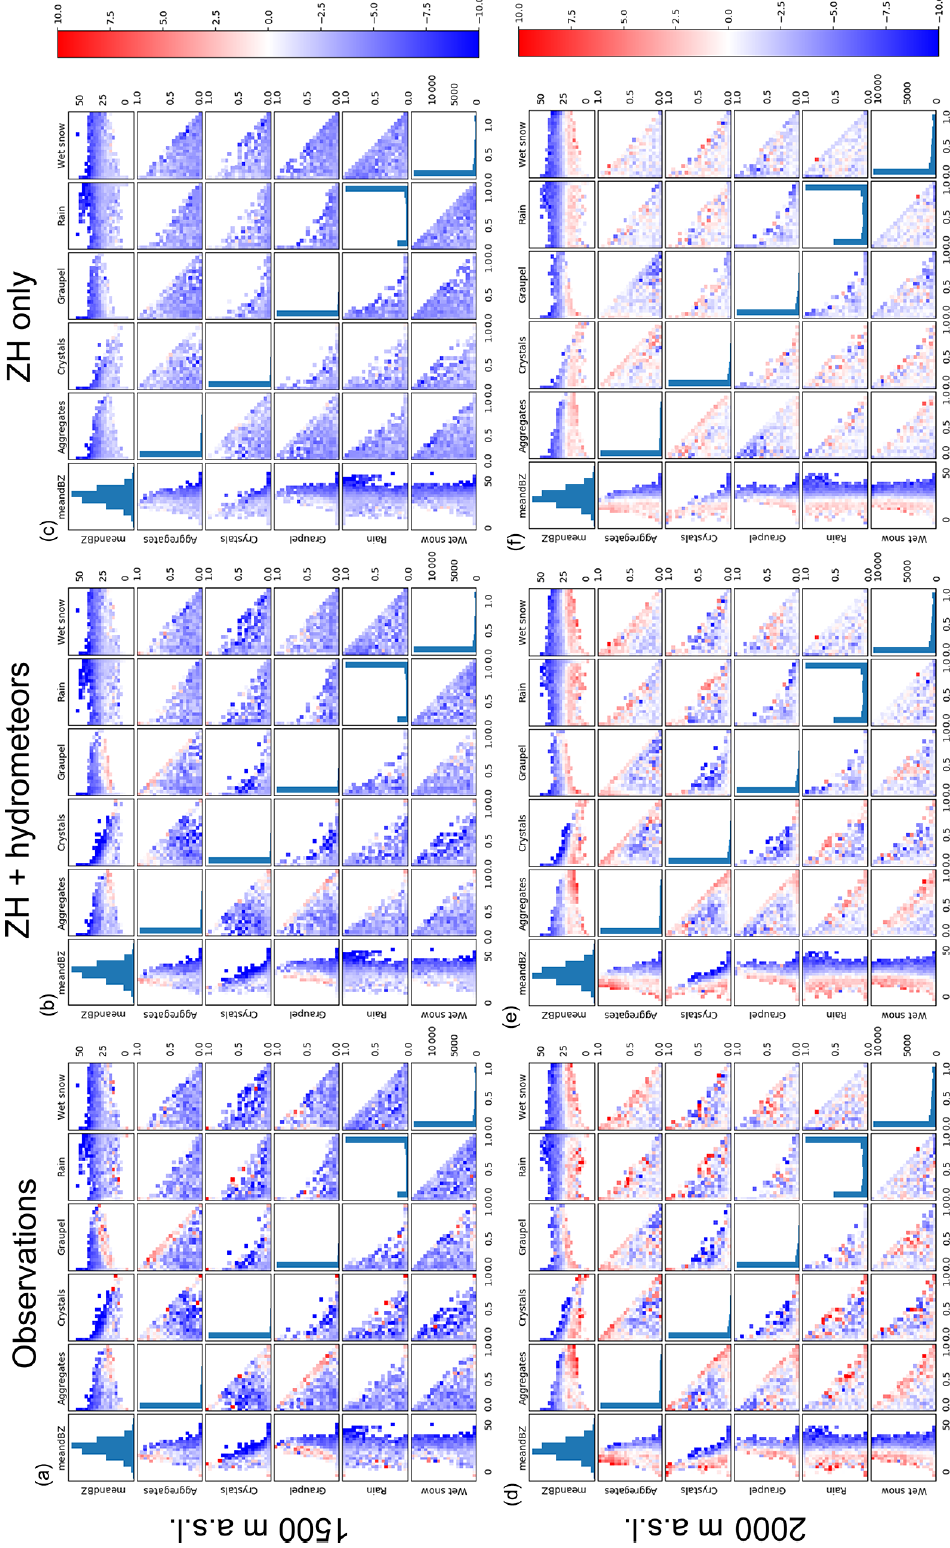
Figure 7. The 2-D growth and decay matrices for 1500ma.s.l. (a, b, c) and 2000ma.s.l. (d, e, f) for the observed data (a, d) , HC + dBZ model (b, e) and dBZ-only model (c, f) . The colour of each bin is based on the average GD